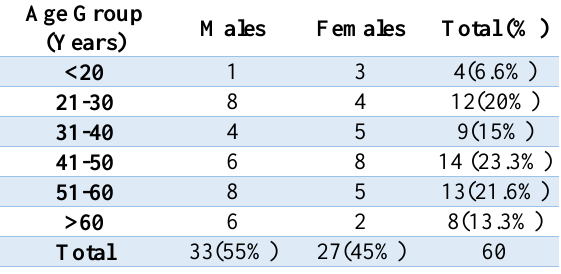
Table 2. Distribution of Cases According to Age and